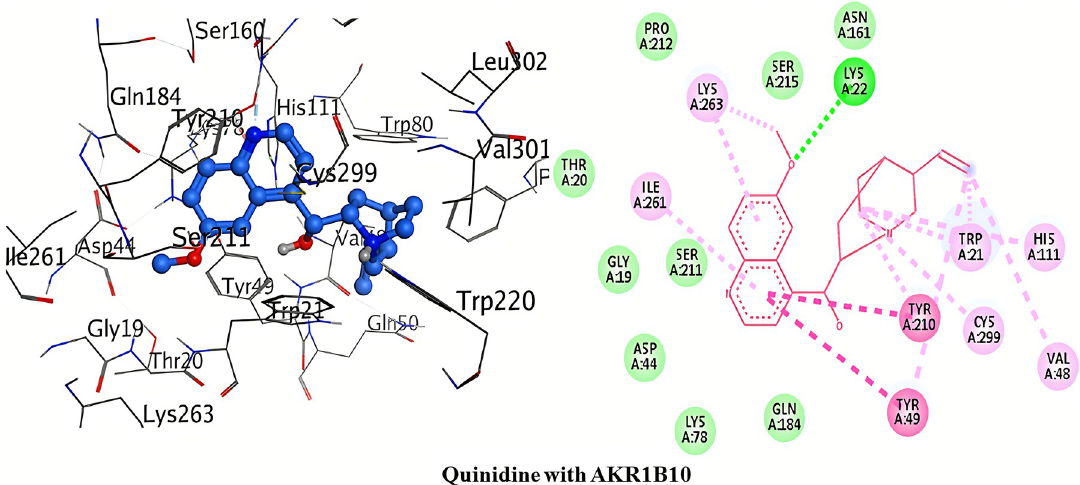
Fig 8. 3D and 2D interactions of quinidine with active site of